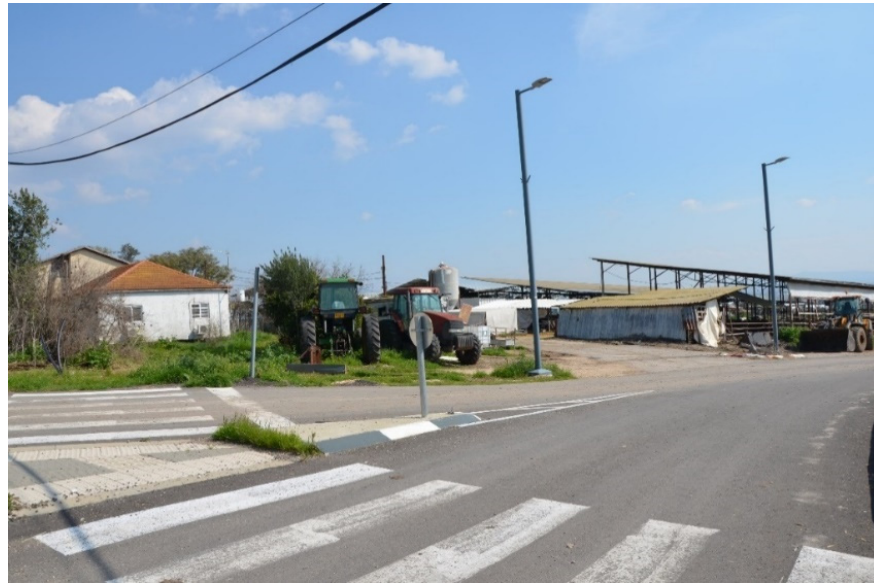
Figure 15. Farm buildings next to the residential units in HaYogev. Photo by the